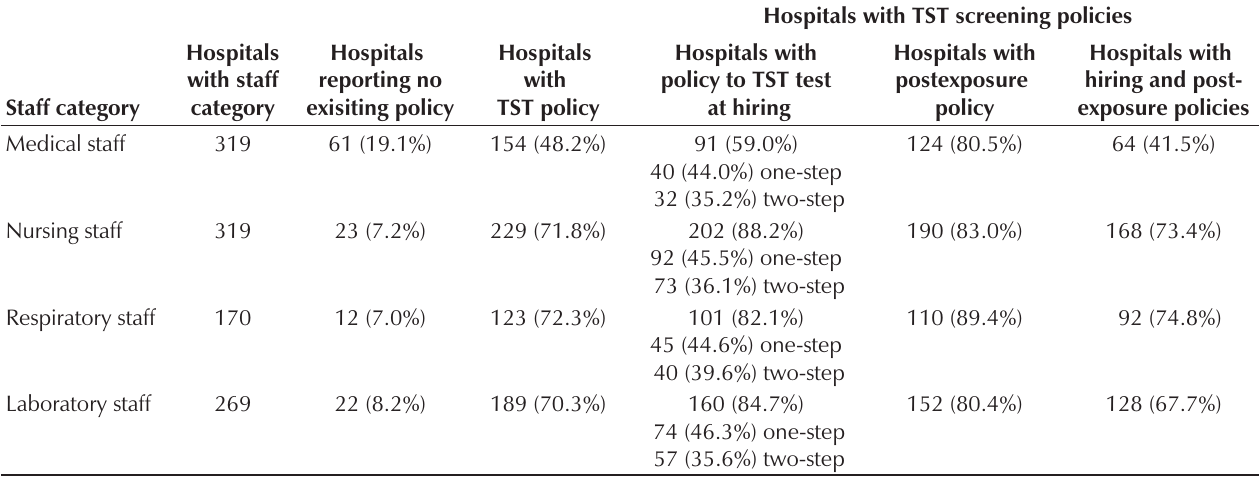
Acute care hospitals performing a tuberculin skin test (TST) at hiring and post-tuberculosis exposure